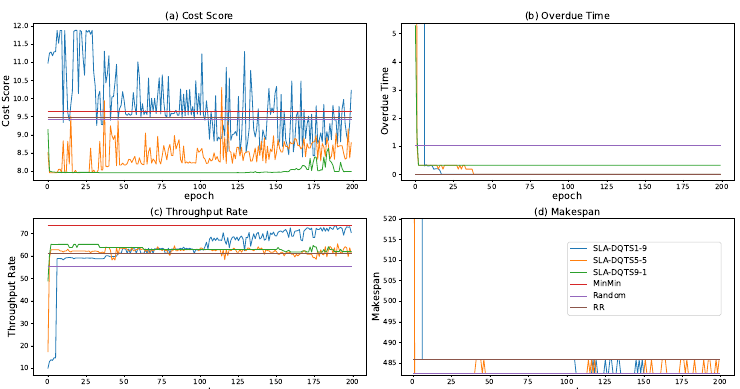
Figure 5. Performance of SAL-DQTS algorithm with different weights and comparison algorithm in a low-load